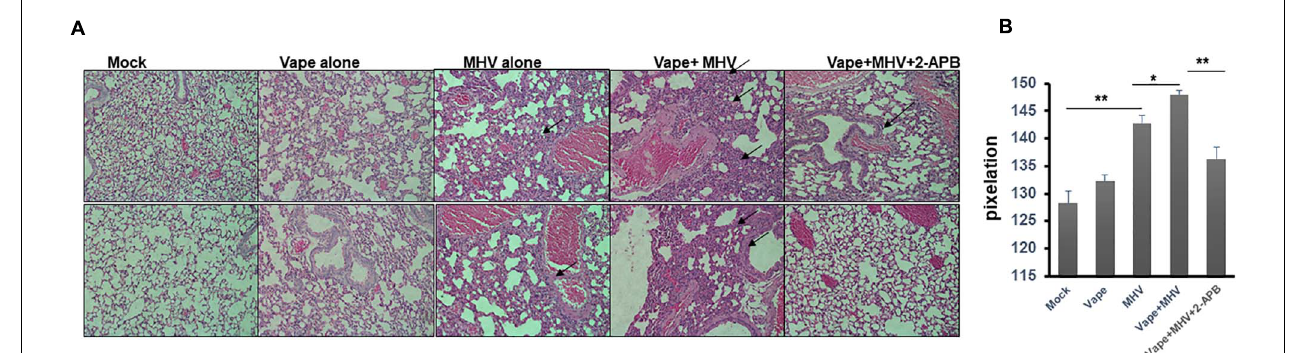
FIGURE 4 | Histopathology indicates that 2-APB treatment reverses some of the effects of MHV infection in mouse lungs. (A) Histopathology of lung tissues. H&E staining of sections of lung tissue isolated from mock-, vape alone-, MHV alone-, vape + MHV-, and vape + MHV + 2-APB-treated mice. Alveolar wall thickening and the infiltration of inflammatory cells into the interstitial spaces were particularly observable in the lungs from the MHV-alone and vape + MHV mice (indicated by arrows). However, these features were much less pronounced in the vape + MHV + 2-APB animals. 200 × magnification. (B) Pixelation was quantified as a measure of inflammatory foci with five images per lung. Student’s t -test was performed between groups. Symbols and bars represent the mean ± SEM compared with the mock control (* P < 0.05, ** P < 0.01). N.S., not